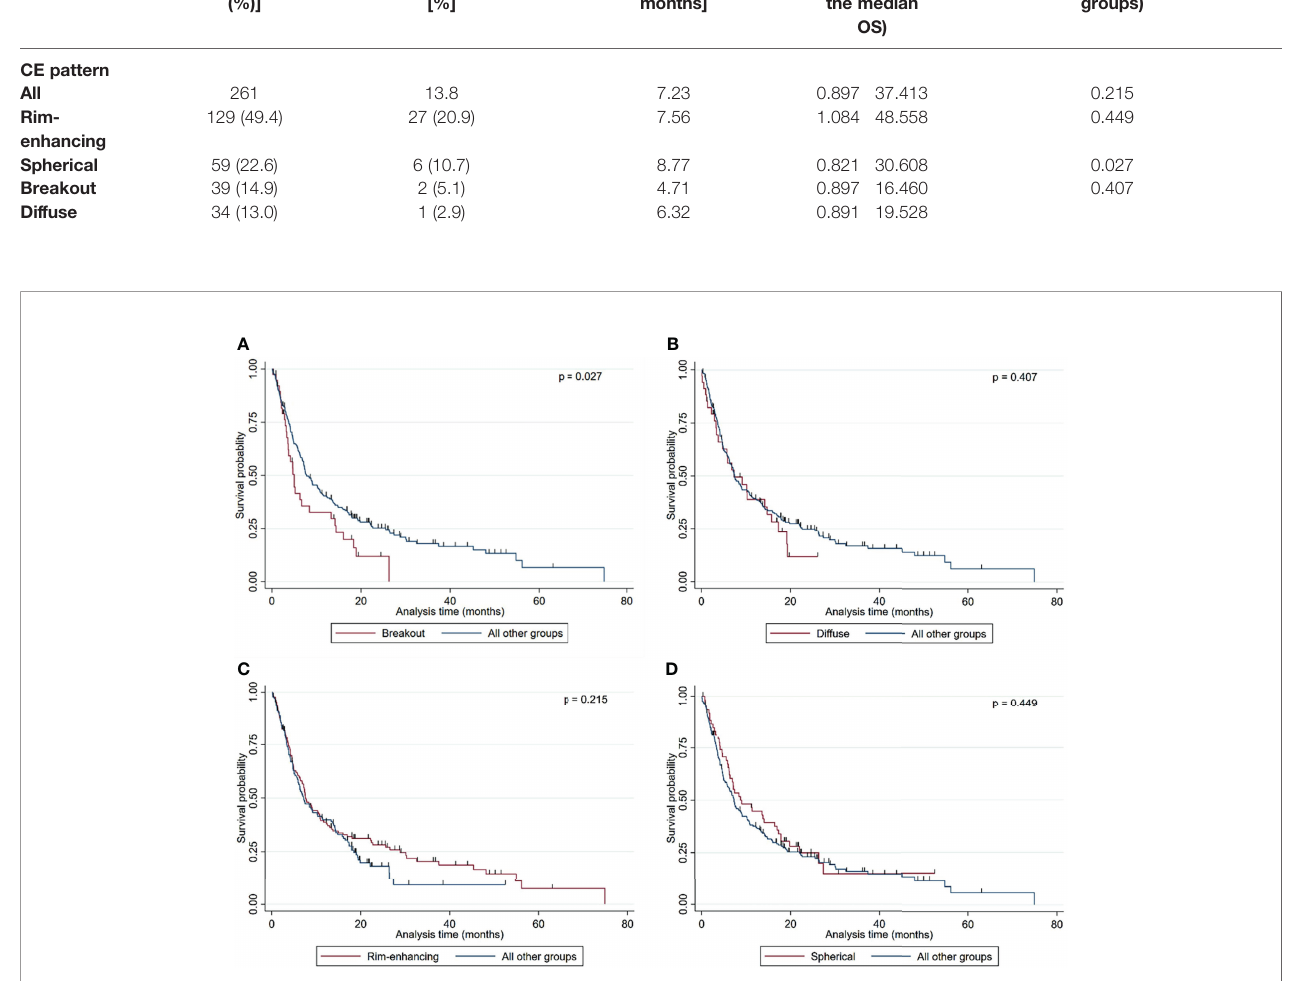
TABLE 1 | Overall survival strati fi ed according to the contrast enhancement pattern on magnetic resonance images.